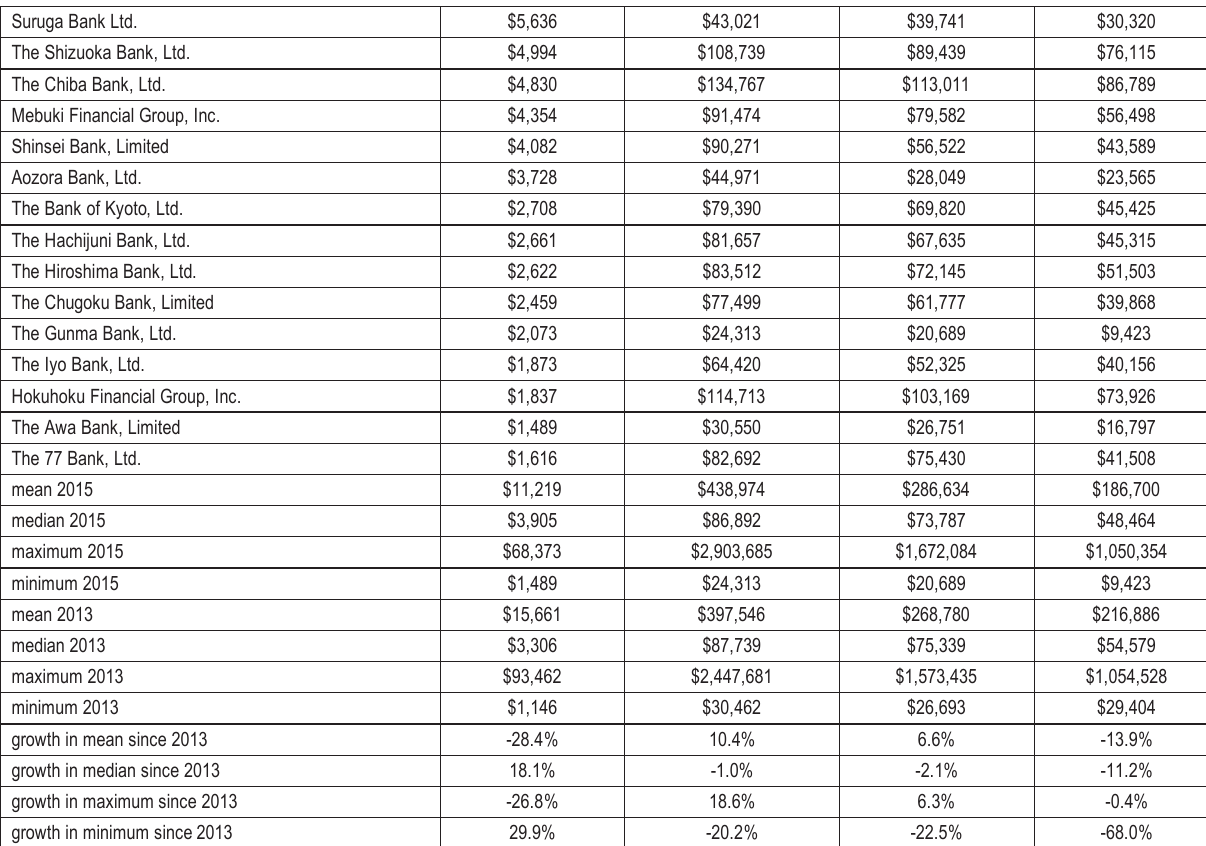
Table 3. Descriptive Statistics. Largest 20 Japanese Banks (in terms of market capitalization) designated as “Banks, Primary” in S&P’s Capital IQ database as of year-end 2015 (values in millions)